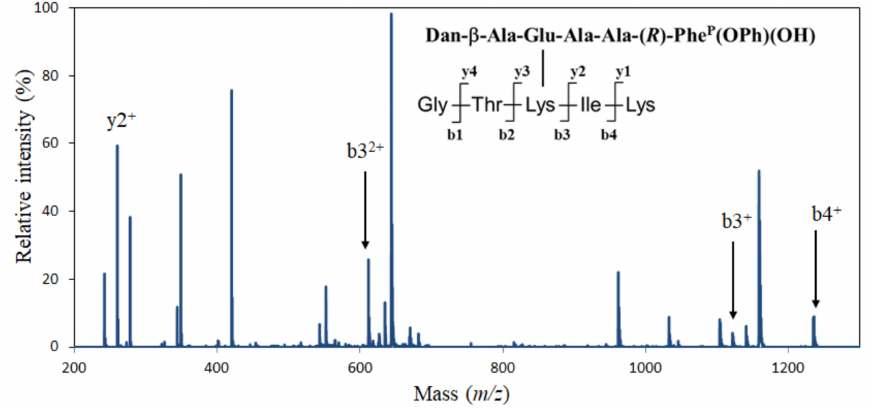
Figure 8. MS/MS analysis of the target ion ( m / z 690.8). For identification of the modified chy- motrypsins, the fragment molecular ion masses were analyzed with an electrospray ionization time-of-flight (ESI-TOF) mass spectrometer on a Hitachi NanoFrontier LC-MS system (Tokyo,